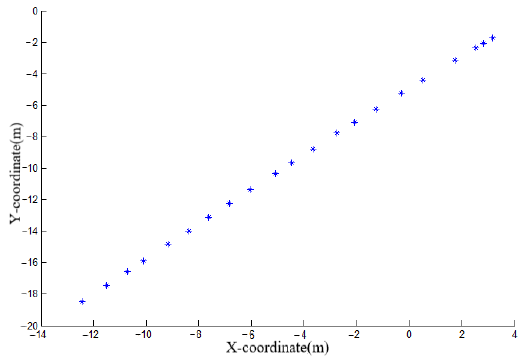
Figure 15. X-Y coordinates of incremental PI strategy.